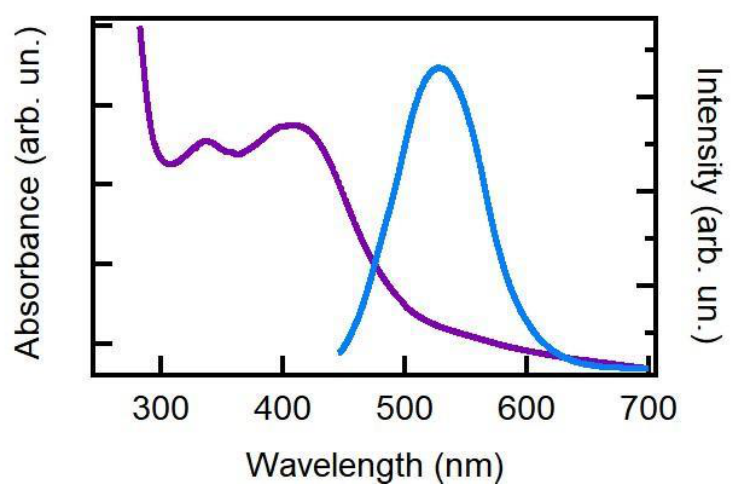
Figure 2. Absorption spectrum of an aqueous solution of C-dots (purple curve) and steady-state emission spectrum of C-dots excited at 440 nm (blue curve).